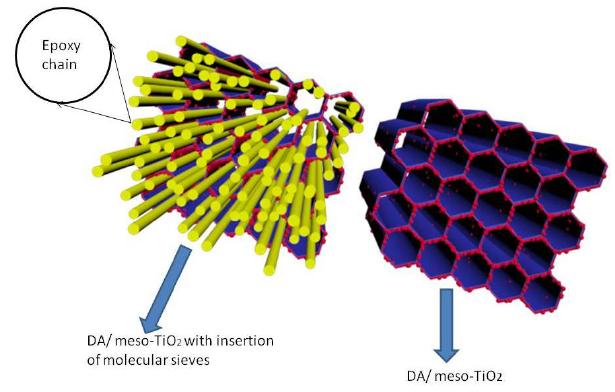
Figure 2. The schematic diagram of nanocomposite model.